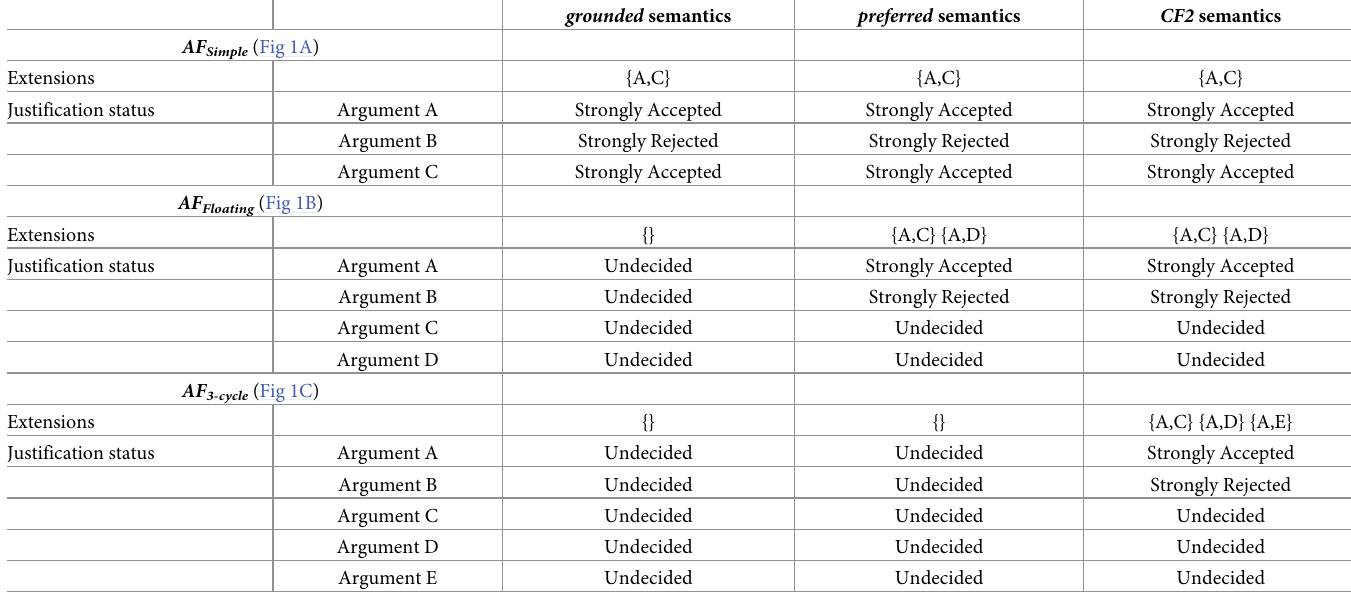
Table 1. Summary of the extensions and justification status for each of the three semantics and the three AF s considered in this